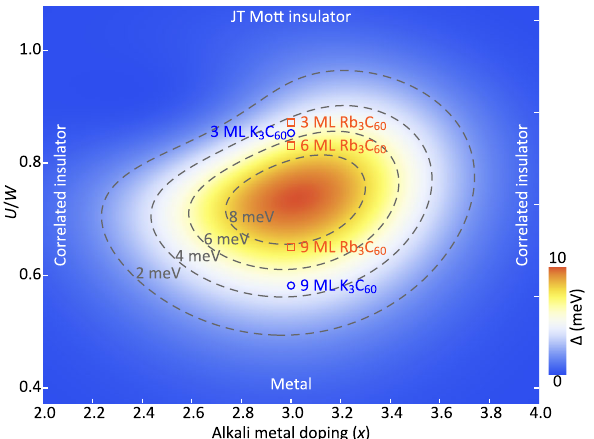
Fig. 5 Uni fi ed phase diagram of Δ variation with electronic correlations U and doping. The empty circles and squares distinctively mark the experimental Δ measured in K 3 C 60 and Rb 3 C 60 fi lms, respectively. Contour plots of Δ with a separation of 2 meV are shown in gray dashes. Note that the fulleride superconductivity is always peaked at half- fi lling at any speci fi c U / W , with W denoting the t 1u